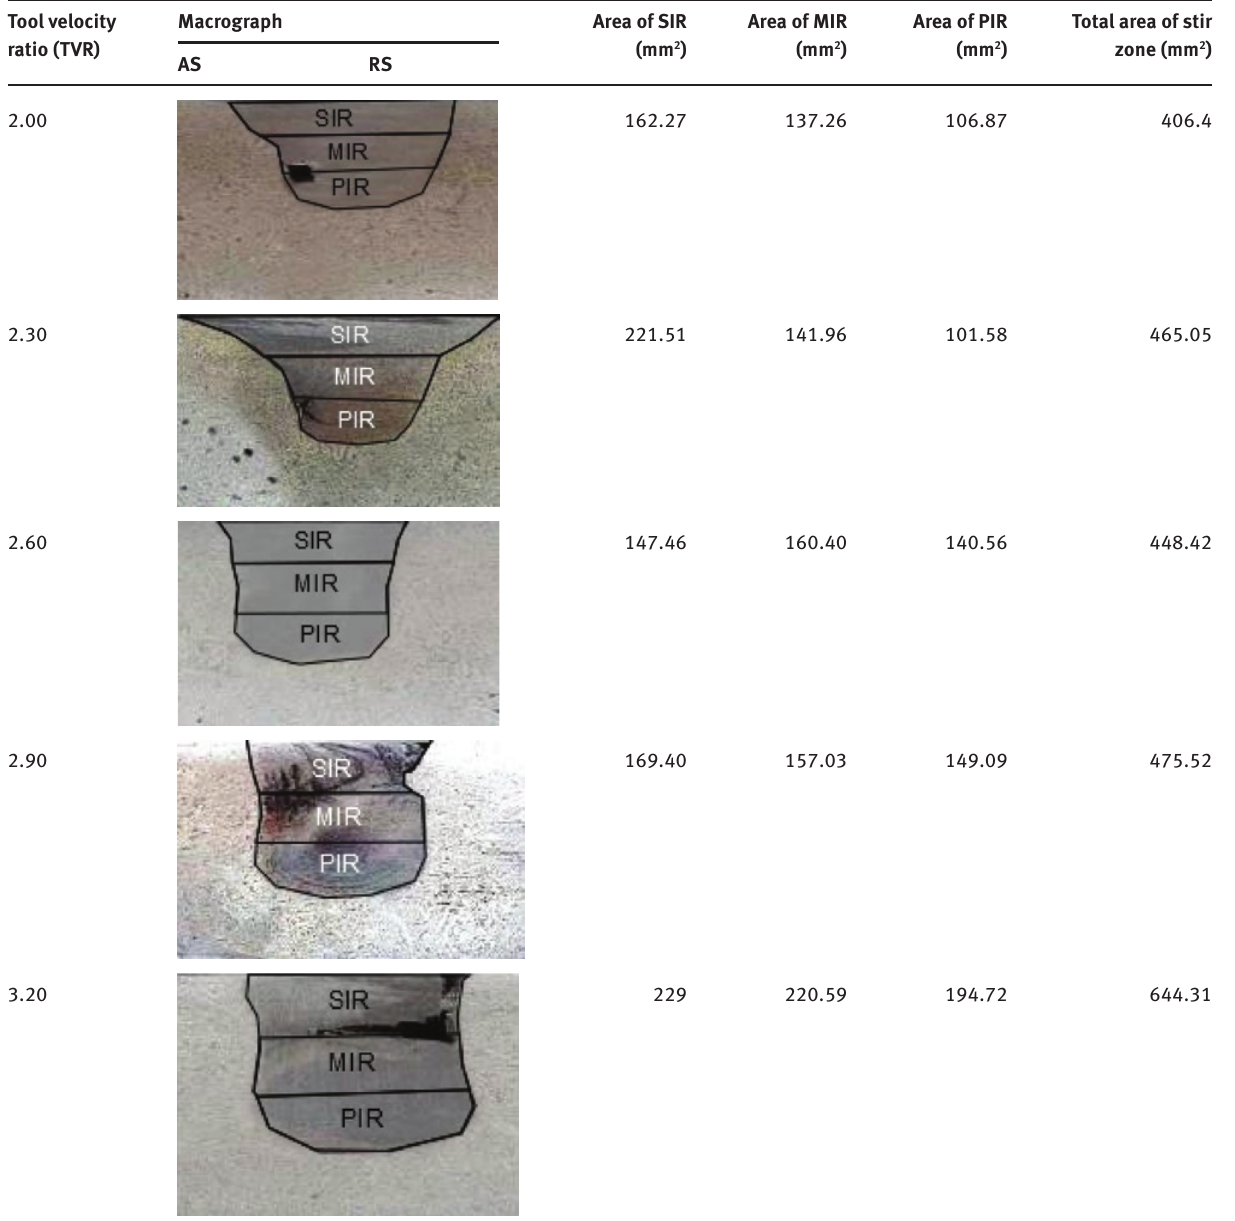
Table 4: Effect of TVR stir zone area